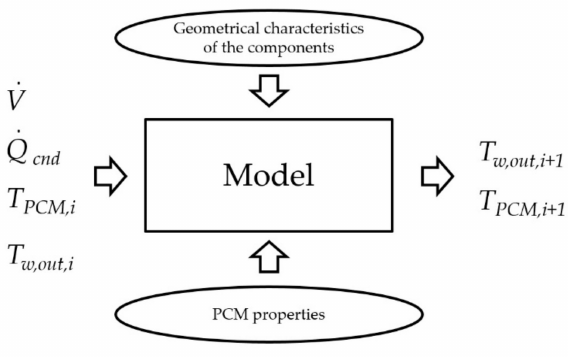
Figure 4. PCM storage tank model structure.